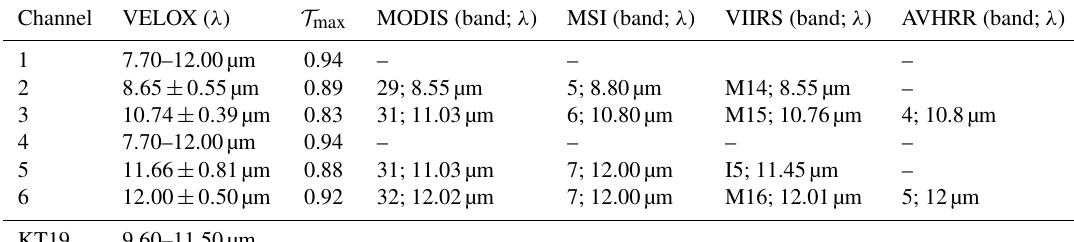
Table 2. List of all VELOX channels. The wavelength ranges ( λ ) of the narrow-band channels are determined by the centre wavelength of the particular filter and its half width. The third column lists the mean maximum transmissivity T max of the channel filters. According to the wavelength ranges, equivalent MODIS, MSI, VIIRS, and AVHRR bands and centre wavelengths are